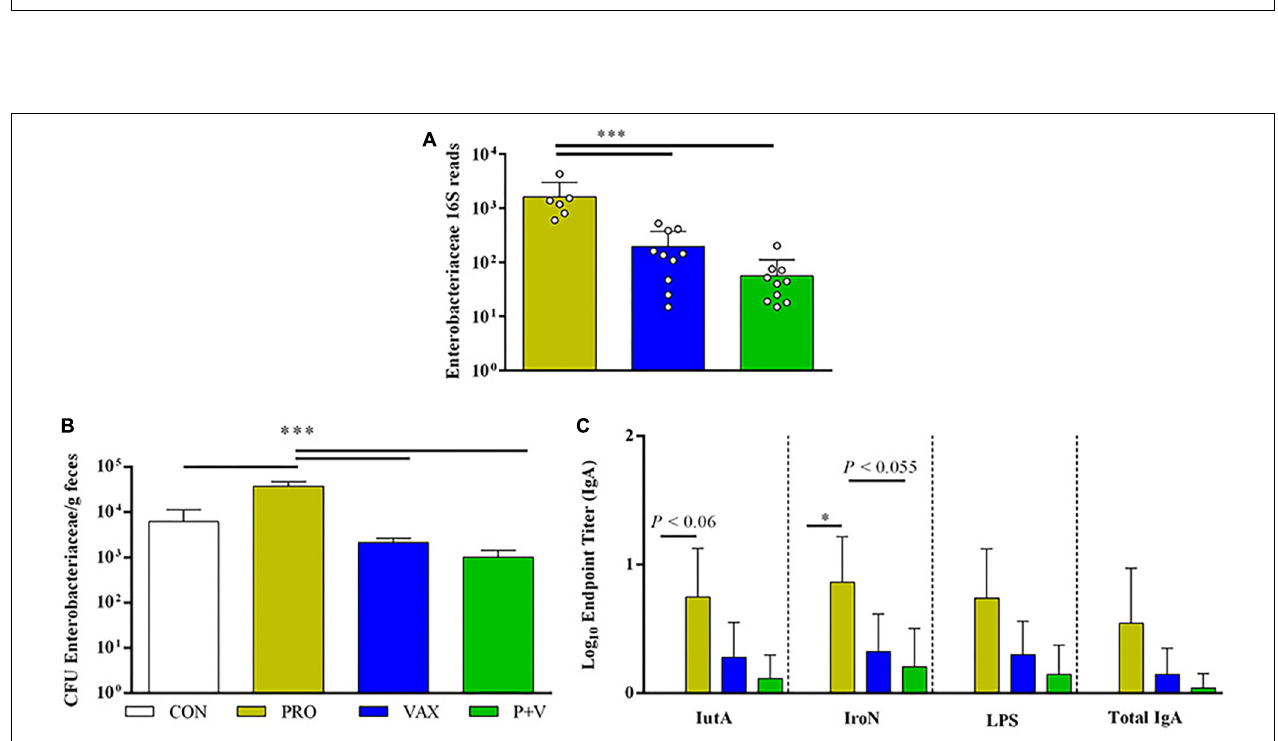
FIGURE 7 | Associations between Enterobacteriaceae levels in ceca, feces and antigen-specific IgA production. (A) Enterobacteriaceae 16S reads generated by QIIME2 ( n = 10 per group). (B) Enterobacteriaceae enumerated on MacConkey from feces ( n = 3 per group, experimentally duplicated). (C) Antigen-specific and total IgA levels in small intestinal scrapings (IutA, aerobactin; IroN, salmochelin; LPS, lipopolysaccharide; experimentally duplicated). White, CON; yellow, PRO; blue, VAX; green, P+V. ∗ P < 0.05; ∗∗ P < 0.01; ∗∗∗ P < 0.001.